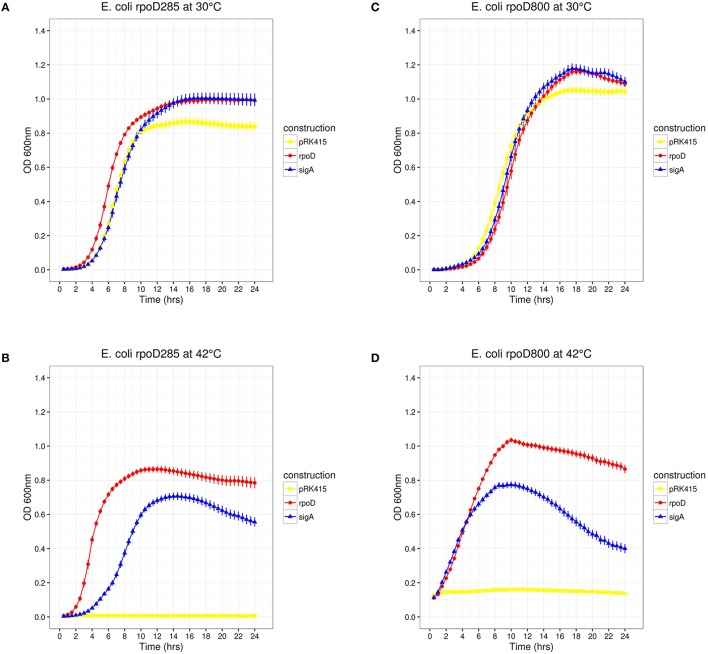
E. coli rpoD285 and rpoD800 complementation experiments. pRK415, yellow squares; pRKrpoD, red circles; and pRKsigA, blue triangles. (A)
rpoD285 at 30°C. (B)
rpoD285 at 42°C. (C)
rpoD800 at 30°C. (D)
rpoD800 at 42°C. Number of repetitions: 20 for E. coli rpoD285 and 10 for E. coli rpoD800 experiments. Error bars denote SEM.